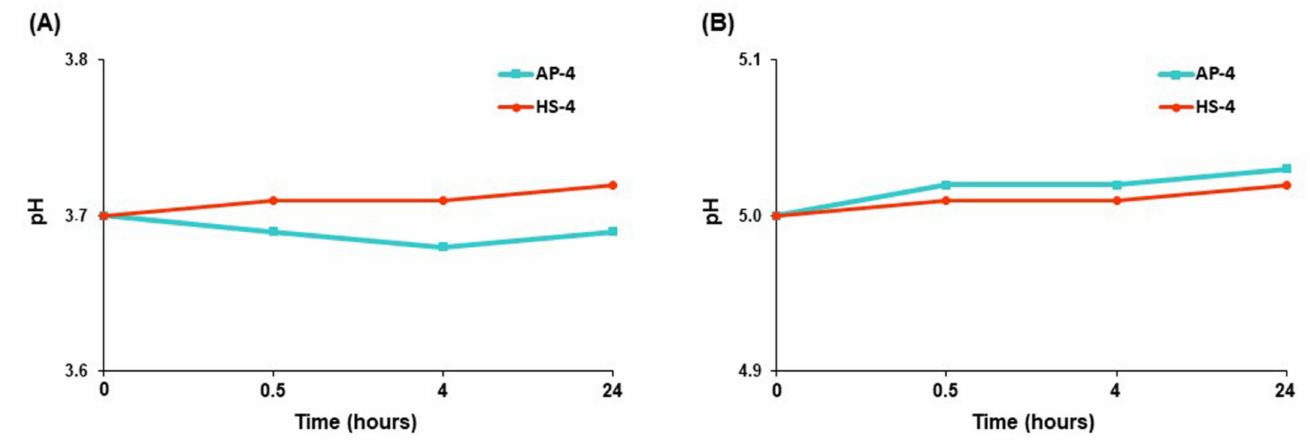
Figure 11. Variation in the pH values during incubation of AP4 and HS4 gel beads for 24 h in acetate buffer solutions of pH 3.7 ( A ) and 5.0 ( B ). The data are presented as the mean ± S.D. ( n = 5). The AP4 gel beads did not degrade but gradually swelled and preserved their shape during incubation in an acetate buffer solution of pH 3.7 (data not shown). The BSA adsorption by AP4 gel beads was remarkably enhanced after 4 h of incubation in an acetate buffer solution of pH 3.7 (Figure 12A). Similar to PBS, HS4 gel beads adsorbed significantly less BSA than AP4 gel beads during incubation in acetate buffer at pH 3.7 (Figure 12A). Both pectin gels adsorbed a relatively low amount of BSA in an acetate buffer of pH 5.0 during 24 h of incubation (Figure 12B).